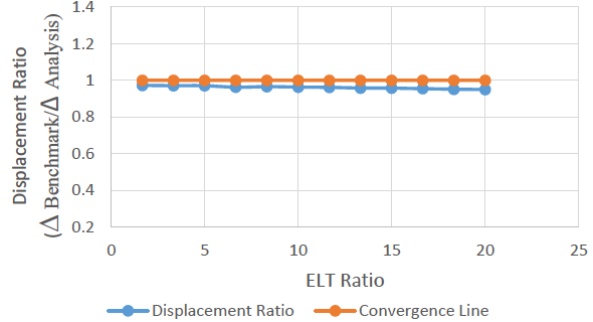
are nodes, elements, maximum stress results, and displace- ment. The mesh convergence study (Figures 3 and 4) with stress ratio is obtained by plotting the stress ratio with the element length to thickness (ELT) ratio; meanwhile, the mesh convergence study with displacement ratio was ob- tained by plotting the displacement ratio with the ELT ratio.